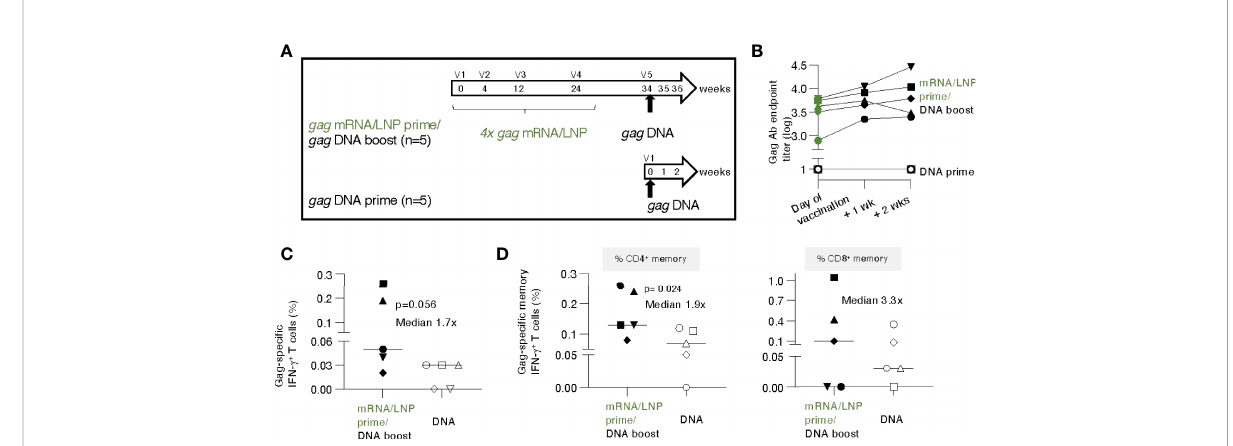
FIGURE 5 gag DNA booster vaccination of macaques primed with mRNA/LNP vaccinations increased T cell responses. (A) Schematic representation of the mRNA/LNP prime - DNA boost vaccination regimen. Five animals previously immunized four times (V1-V4) with gag mRNA/LNP (group 2, 25 m g dose, described in Figure 1) received a single gag DNA vaccination (V5; 2 mg dose) at 10 weeks after the last mRNA/LNP vaccination (V4). A group of naïve macaques (n=5) received a single gag DNA vaccination and was added for comparison. The gag DNA vaccine was administered by IM injection followed by electroporation. (B) Gag Ab titers after the single DNA vaccination were plotted over time. (C, D) Gag-speci fi c cellular analysis was performed by fl ow cytometry two weeks after the DNA vaccination. (C) Total Gag-speci fi c (CD3 + IFN- g + ) T cell responses as % of total T cells and (D) Gag-speci fi c memory (CD3 + CD95 + IFN- g + ) T cell responses are shown. The percent of Gag-speci fi c IFN- g + CD4 + (left panel) and CD8 + (right panel) memory T cells in blood were plotted. The p values are from t test